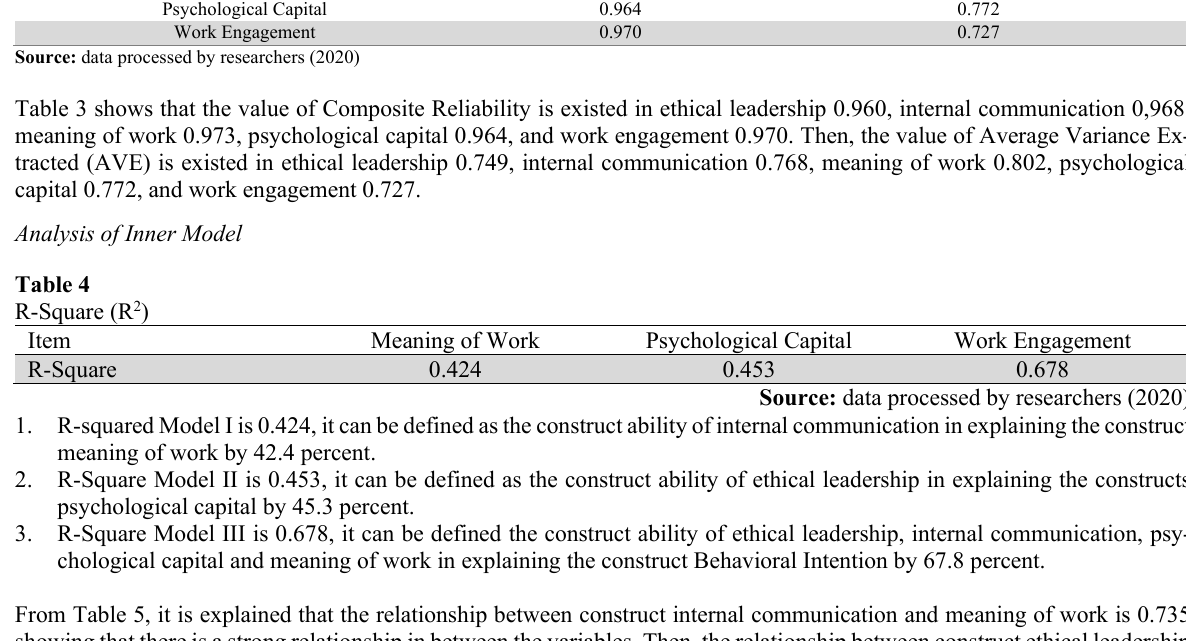
Composite Reliability